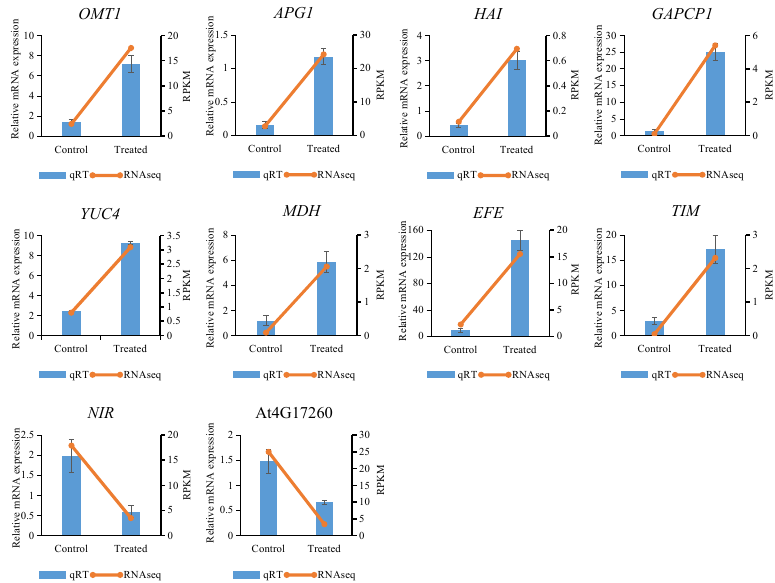
Figure 6. The gene expression analysis of metabolic pathway genes in toluene treated and untreated A. pusilla plants. Values are means of three biological repeats. Error bars indicate ± SE. OMT1: O-methyltransferase 1; APG1: S-adenosyl- l-methylionine-dependent methyltransferases superfamily protein; HAI: H [+]—ATPase 1; GAPCP1: glyceraldehyde-3- phosphate dehydrogenation of plastid 1; YUC4: flavin binding monooxygenase family protein; MDH: malate dehydrogenase; EFE: ethylene forming enzyme; TIM: triosephosphate isomerase; NIR: nitrite reductase 1; AT4G17260: lactate/malate dehydrogenase family